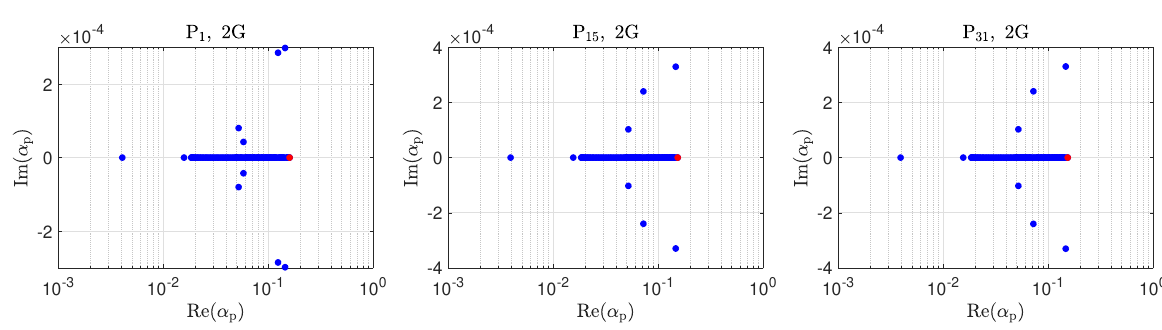
Figure 6: α prompt eigenvalue distribution for a symmetrically reflected system.